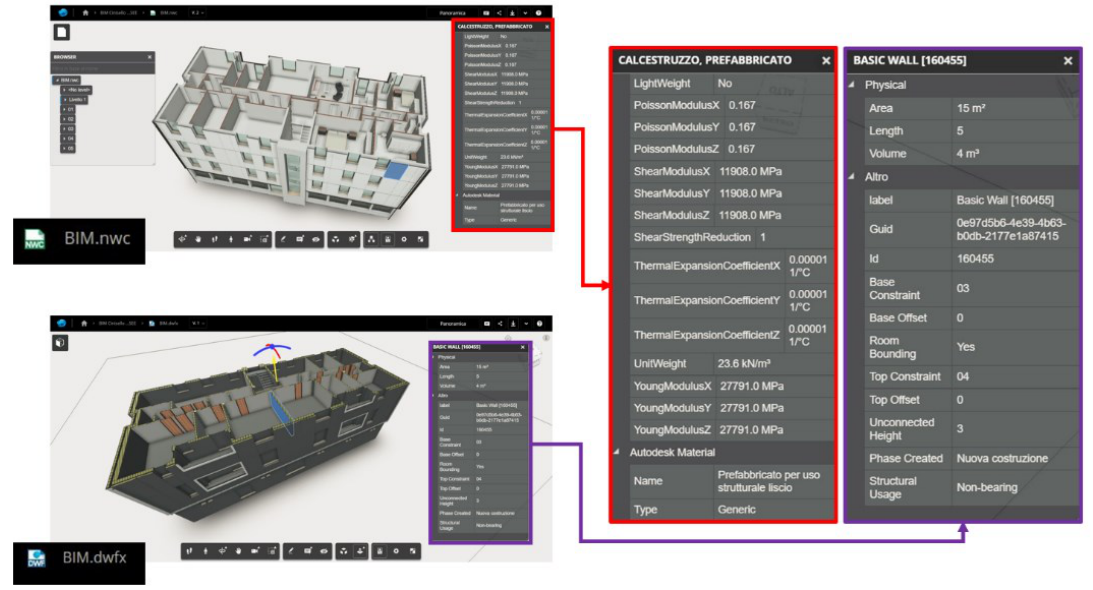
Figure 16. Data visualisation tests: the XR web platform reworked a large number of Data Visualisations and BIM 360 APIs.